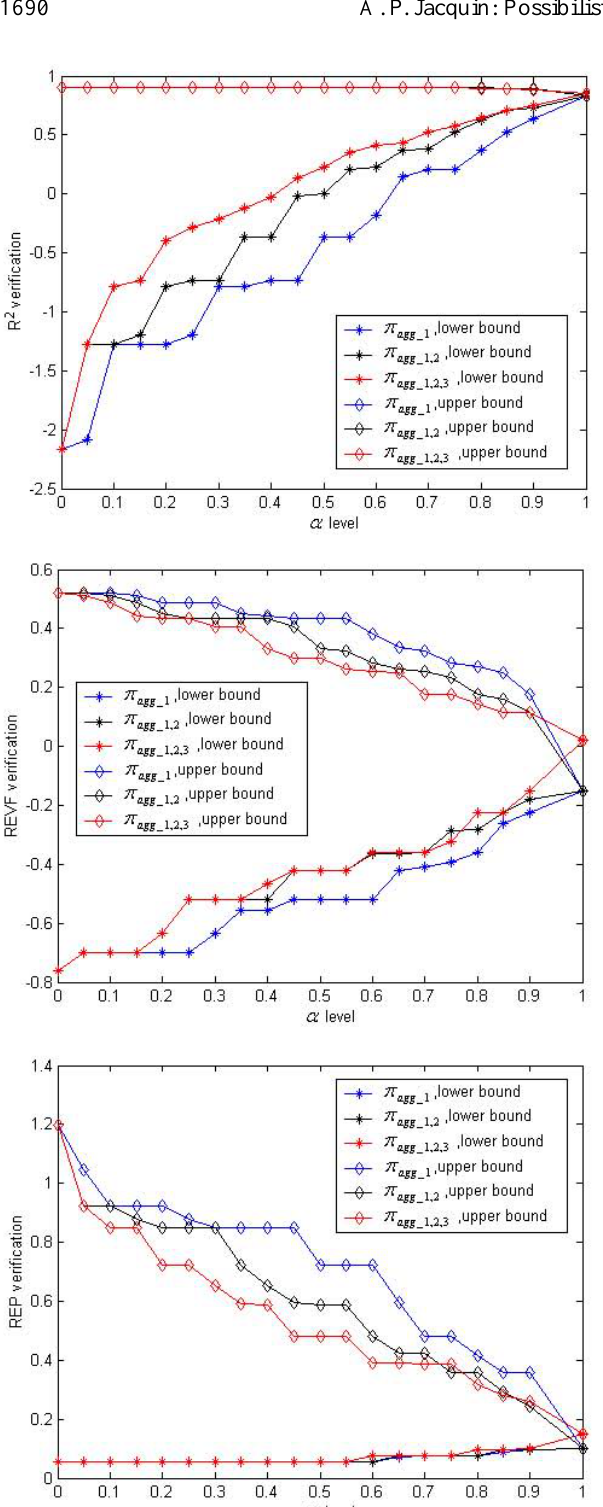
Fig. 4. Ranges of model performance statistics during the verifica- tion period of the simulations retained above given possibility levels